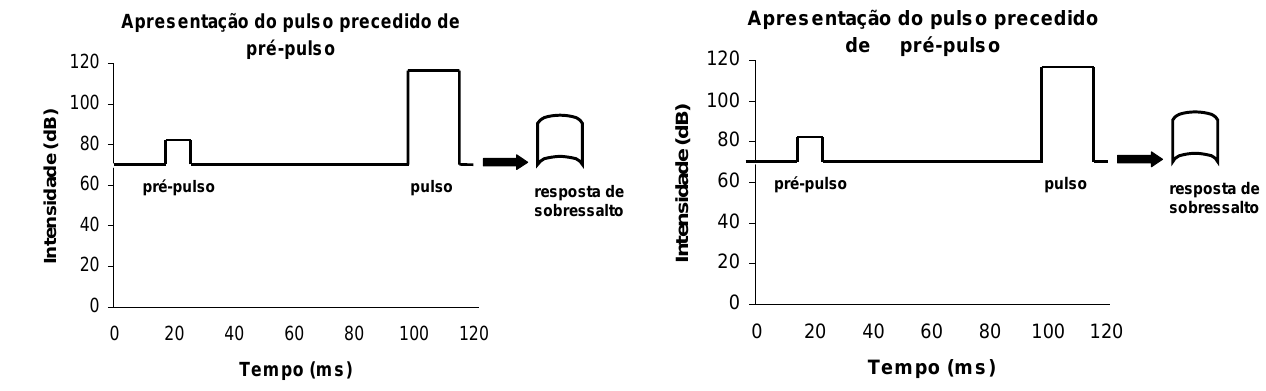
Figura 2 . Esquema simplificado do mecanismo de inibição pré-pulso (IPP). A IPP é caracterizada por uma redução na amplitude do sobressalto que ocorre em resposta a um estímulo auditivo intenso (pulso), quando este é precedido imediatamente (30-500 ms) por um estímulo mais fraco (pré-pulso). Reflexo de sobressalto em resposta ao pulso (Figura 2A) e reflexo de sobressalto em resposta ao pulso precedido de pré-pulso (Figura 2B). Modificadas de Braff et al.